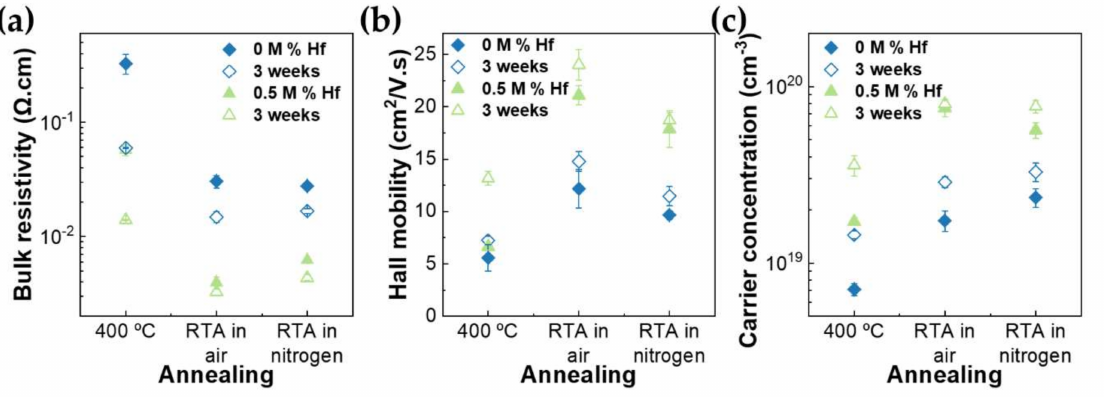
Figure 6. ( a ) Bulk resistivity ( Ω .cm), ( b ) Hall mobility (cm 2 /V.s) and ( c ) carrier concentration (cm − 3 ) of undoped and Hf-doped In 2 O 3 thin films with distinct post-deposition